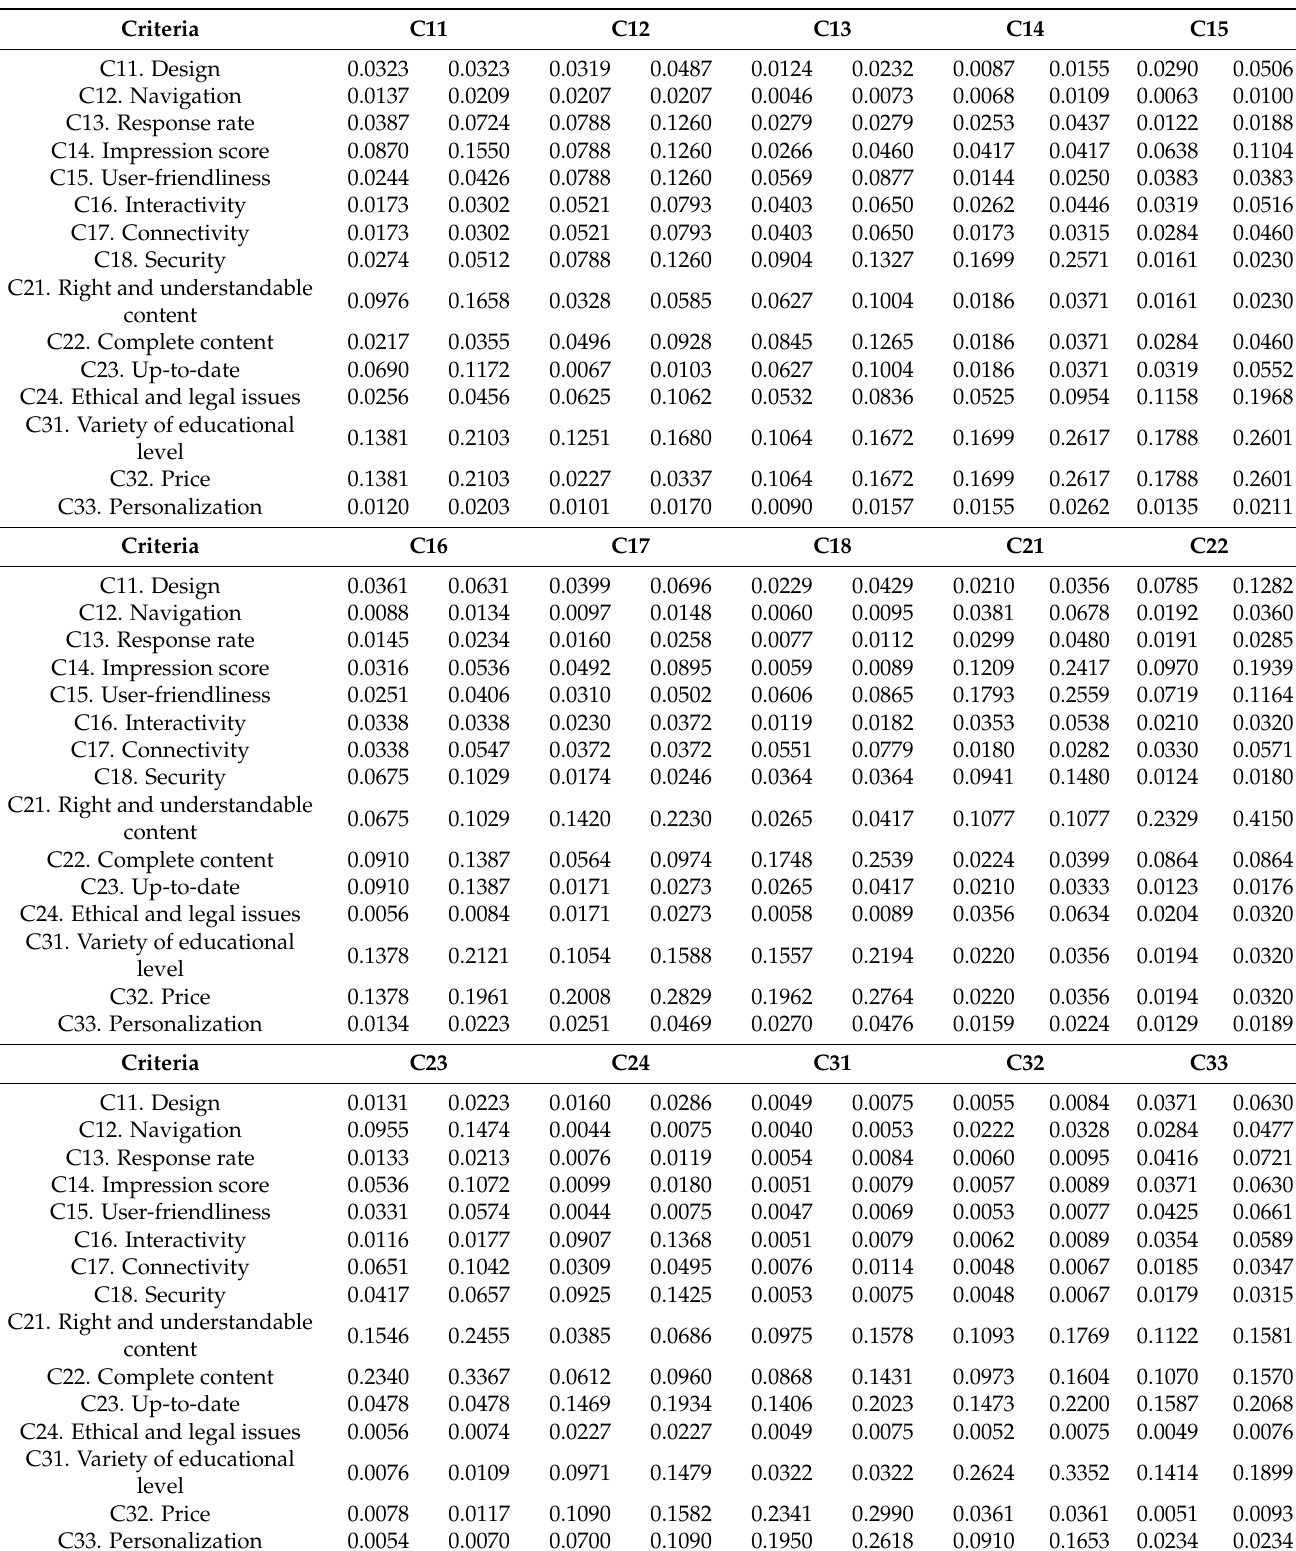
Table A1. The normalized grey comparison matrix used in the G-AHP